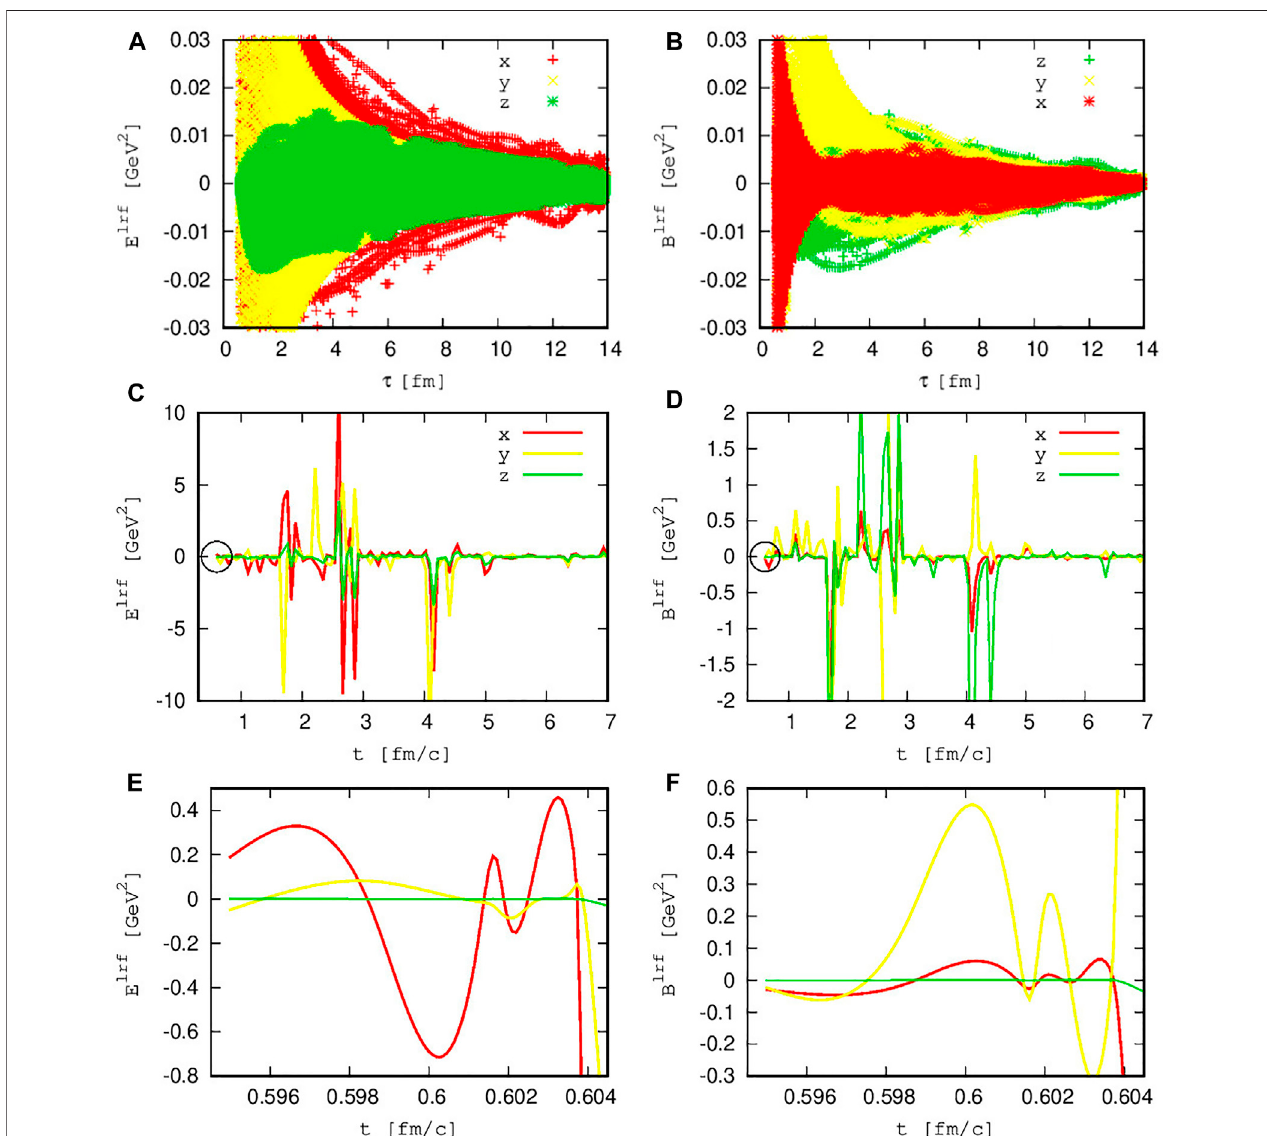
FIGURE 2 | (Color online) (A) Evolution of the three components of the electric fi elds in the local fl uid rest frame at points on the freeze-out surface created in (cid:4) √ (cid:1) 2.76 ATeV. The calculations were made at centrality ranging from 20 to 30% (impact parameters in the range relativistic Pb + Pb collision with collision energy of s 6.24 fm < b < 9.05 fm) and η s ranging from − 7.9 to 7.9, where z is the reaction axis, while xand y represent the transverseand longitudinal directions, respectively. (B) Evolution of the three components of the magnetic fi elds in the local fl uid rest frame at points on the freeze-out surface created in relativistic Pb + Pb collision with (cid:4) √ (cid:1) 2.76 ATeV. The calculations were made at centrality ranging from 20 to 30% (impact parameters in the range 6.24 fm < b < 9.05 fm) and η collision energy of s ranging from − 7.9 to 7.9. (C) The three components of the electric fi elds versus the local time in the fl uid rest frame at a fi xed space time rapidity of η s (cid:1) 0. (D) The three components of the magnetic fi elds versus the local time in the fl uid rest frame at a fi xed space time rapidity of η s (cid:1) 0. (E) The magni fi ed version of the circled part from fi gure (b), showing the three components of the electric fi eld evolution during the very early propagation time in the fl uid rest frame at a fi xed space time rapidity of η (F) Themagni fi edversionofthecircledpartfrom fi gure(d),showingthethreecomponentsofthemagnetic fi eldevolutionduringtheveryearlypropagationtimeinthe fl uid rest frame at a fi xed space time rapidity of η s (cid:1)